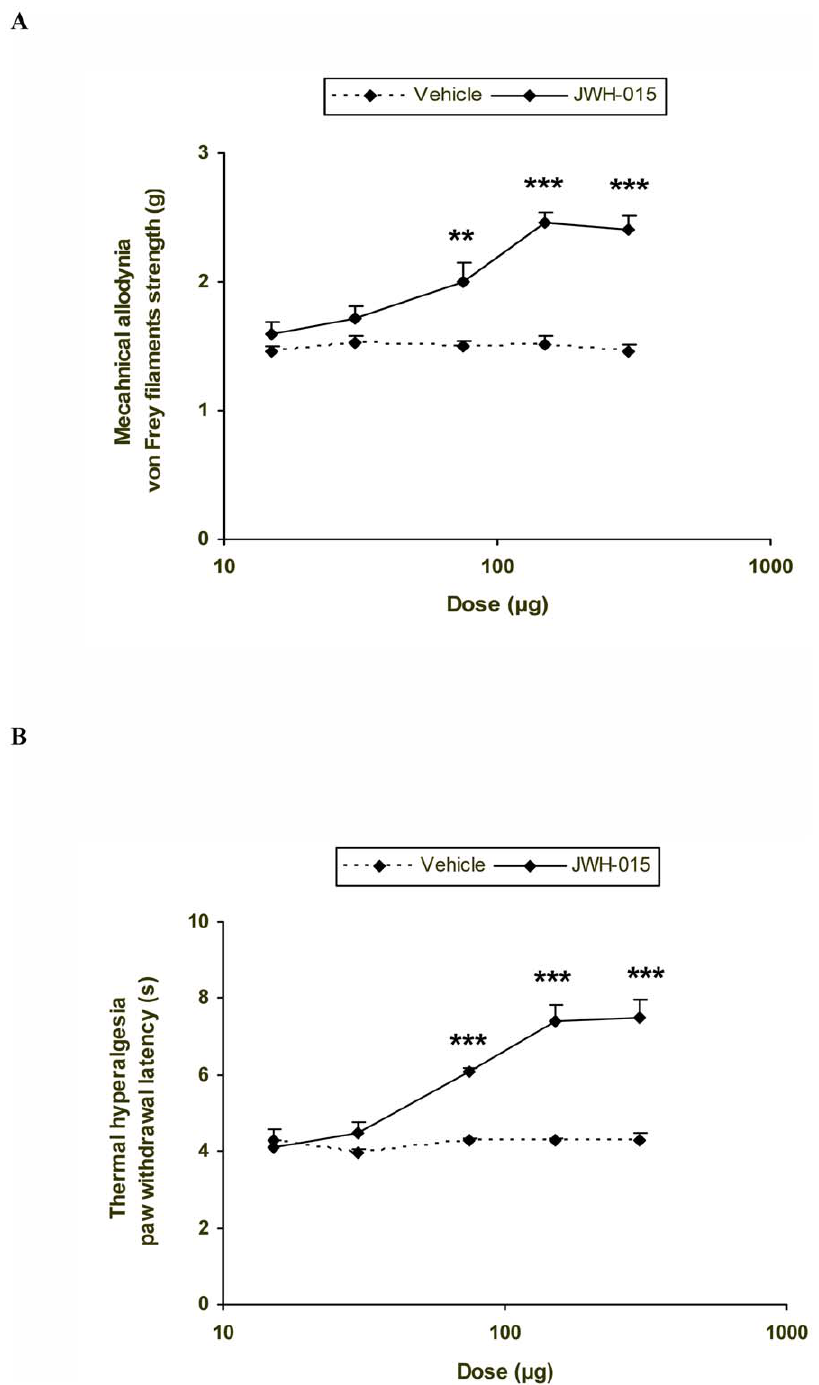
Figure 1. The antiallodynic and antihyperalgesic effects of JWH-015. Effects of the subplantar administration of different doses (logarithmic axis) of JWH-015 or vehicle on the mechanical allodynia (A) and thermal hyperalgesia (B) induced by CFA, in the ipsilateral paw of WT mice at 10 days after their injection. JWH-015 was administered 20 min before starting behavioral testing. Data are expressed as mean values of the von Frey filaments strength (g) for mechanical allodynia and as the paw withdrawal latency (s) for thermal hyperalgesia 6 SEM (5–6 animals per dose). In both tests, for each dose, ** p , 0.01 and *** p , 0.001 denotes significant differences between JWH-015 and vehicle treated animals (Student’s t test).